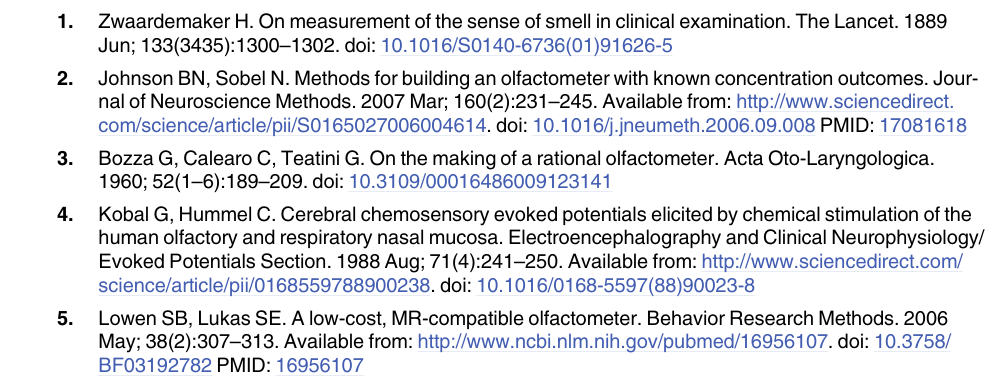
S1 Table. Gas chromatography data. (ODS) S1 Data. RAW data presented in Fig 7. (MAT) S2 Table. Subjective ratings of odor intensities. (ODS)